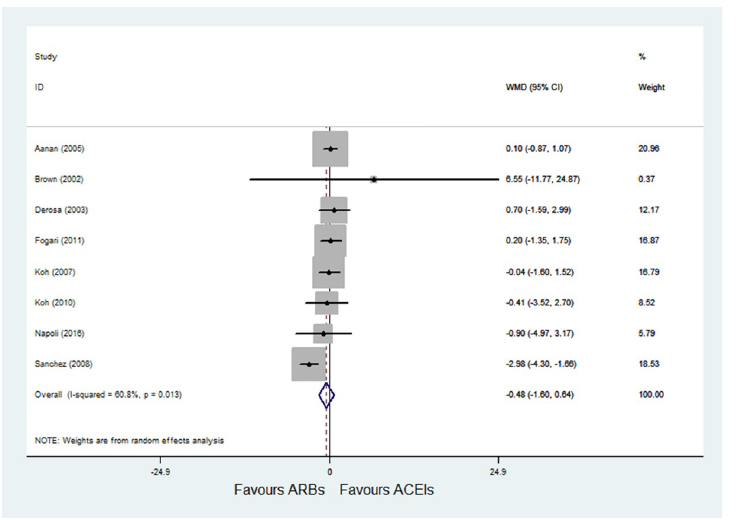
Fig 5. Effect of ARBs versus ACE inhibitors on fasting plasma insulin.